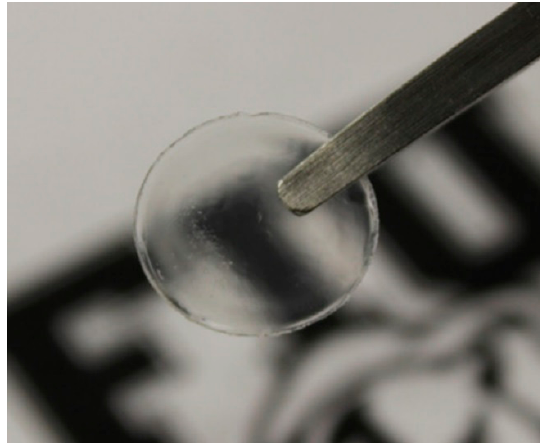
Figure 8. Gel polymer electrolyte (GPE) demonstrating its free-standing property [15]. Reprinted